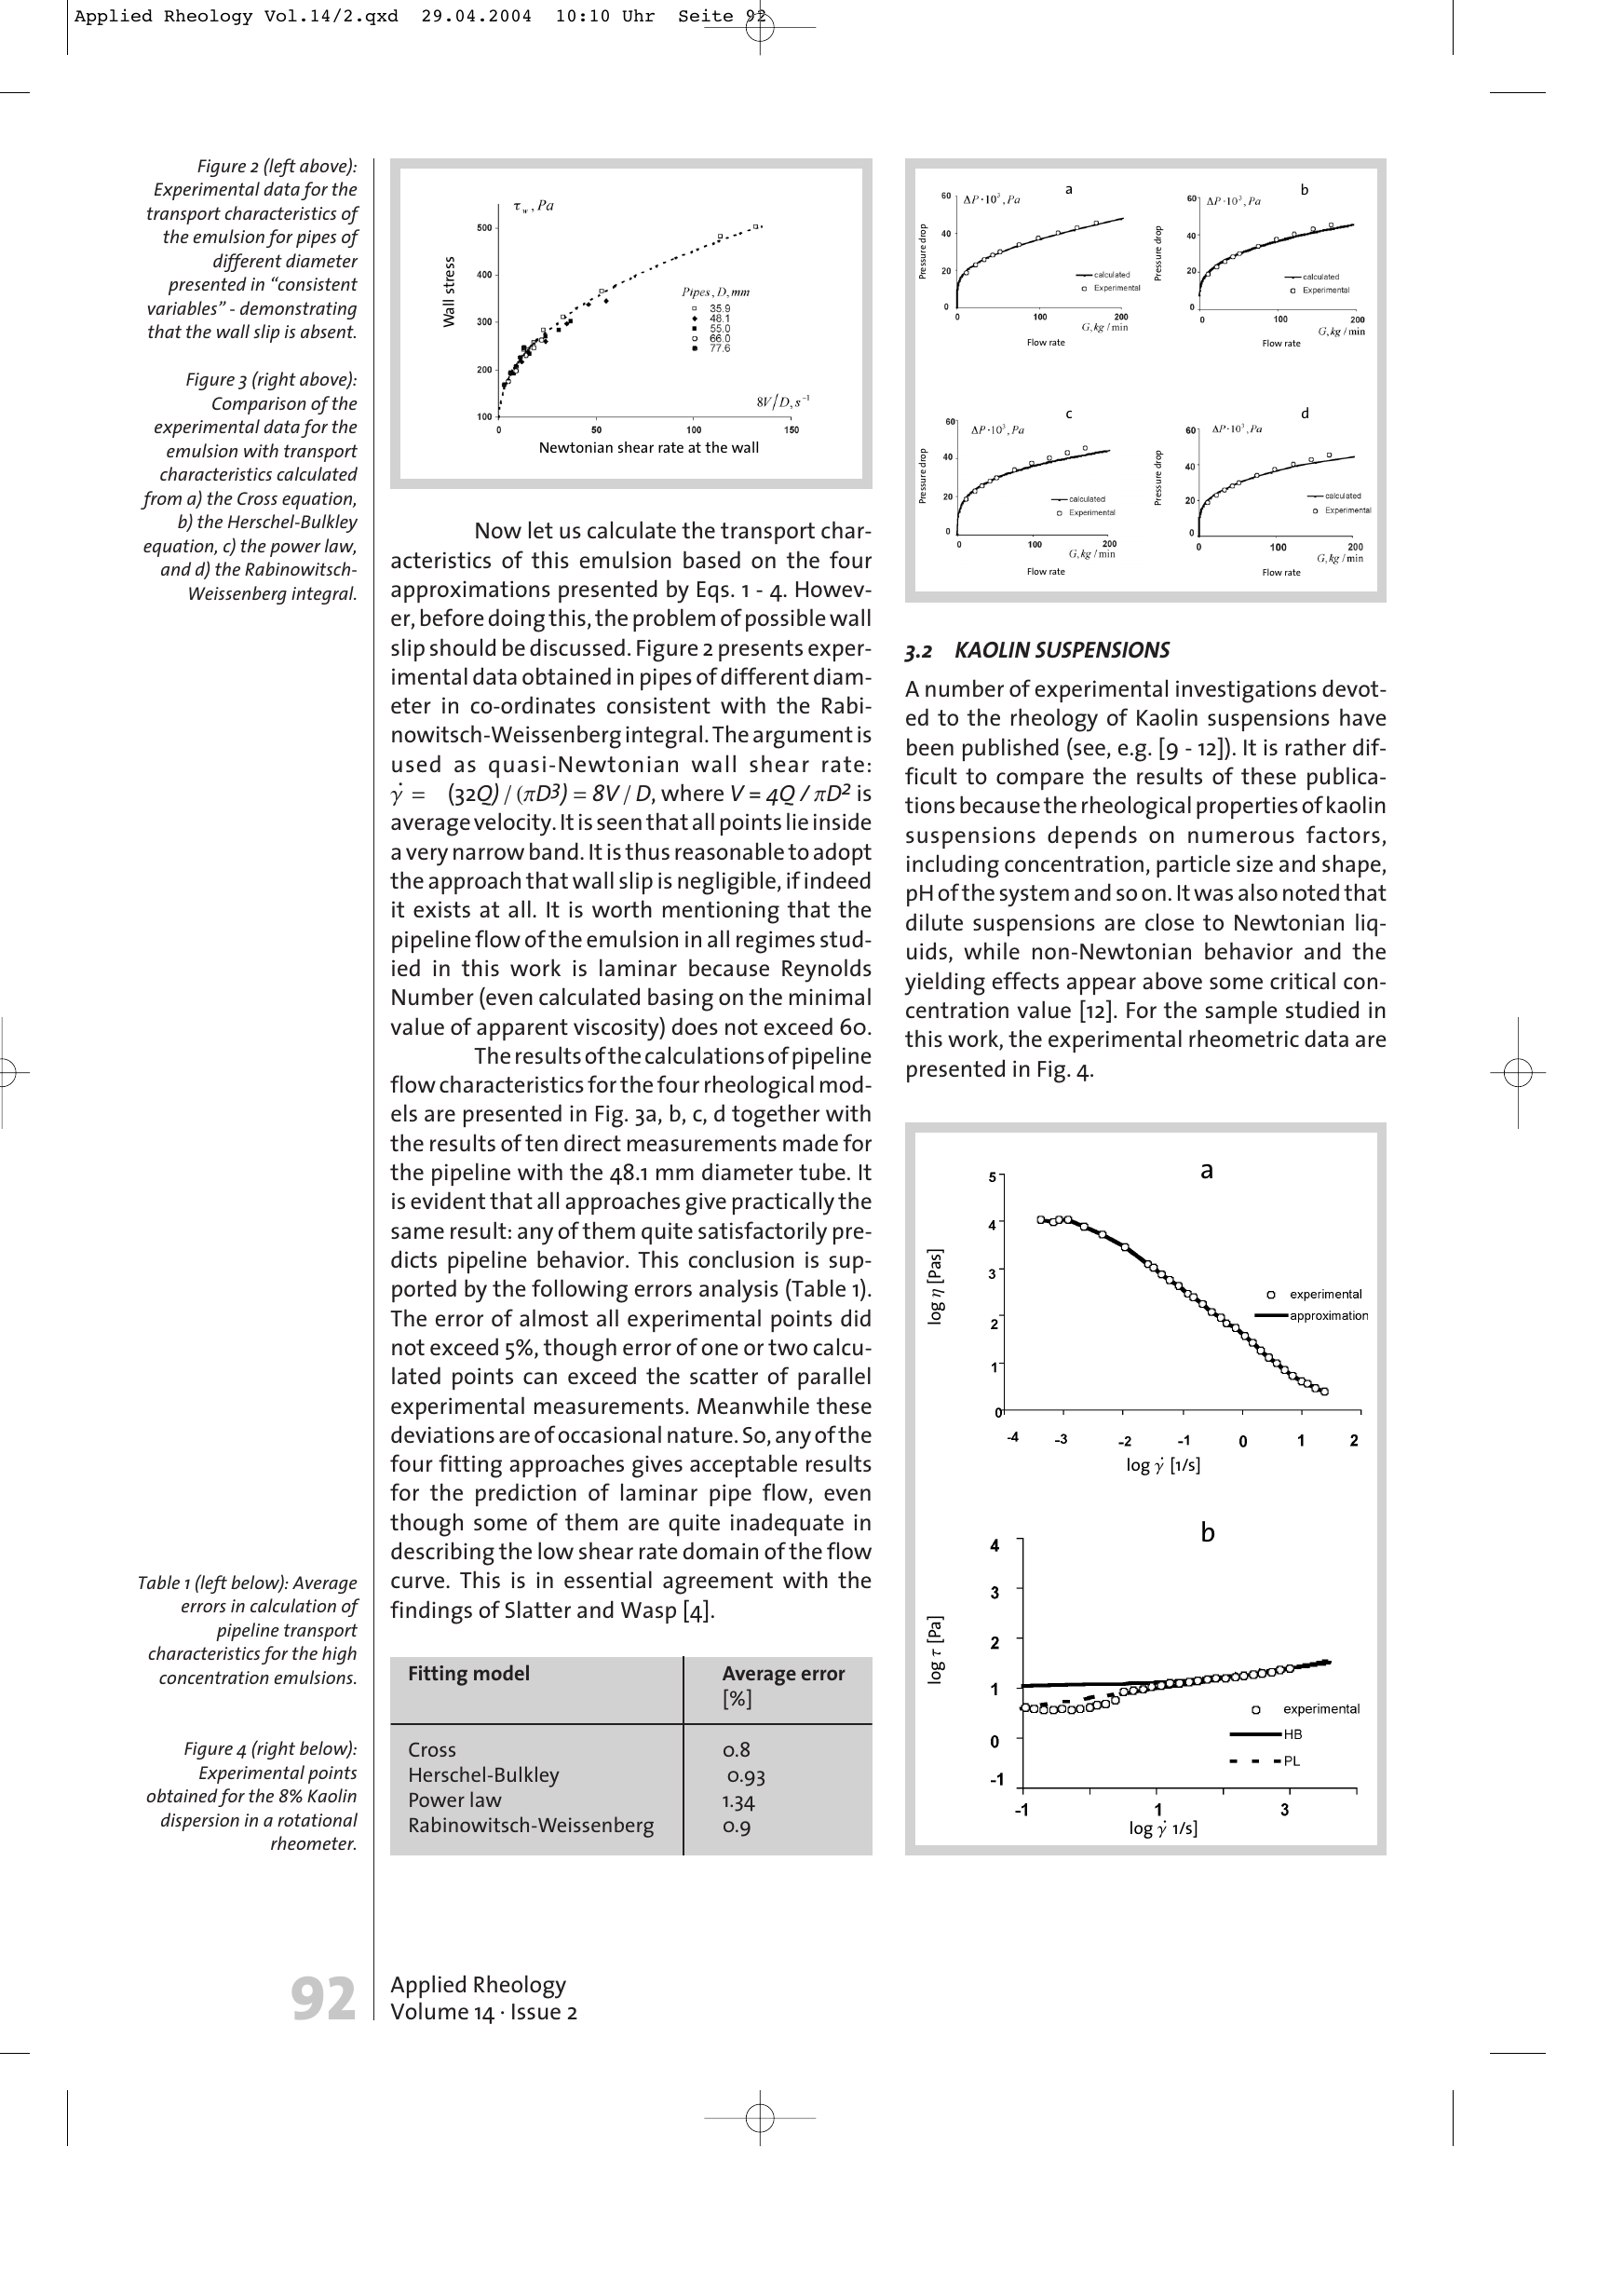
Figure 4 (right below): Experimental points obtained for the 8% Kaolin dispersion in a rotational